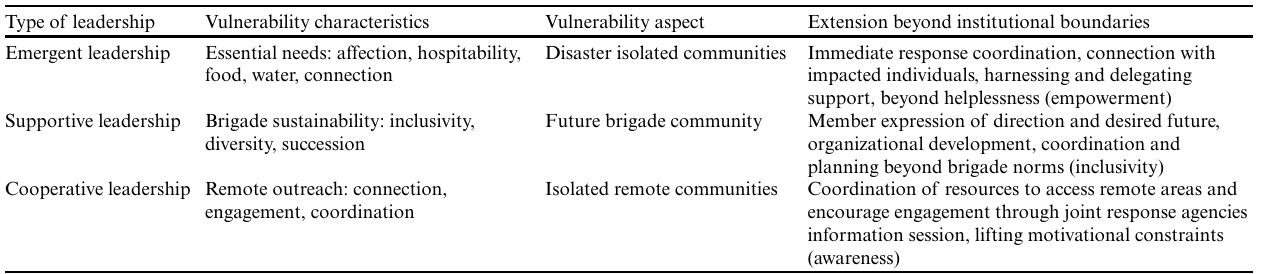
Table 2 . Type of leadership, vulnerability characteristics and aspect, and extension beyond institutional